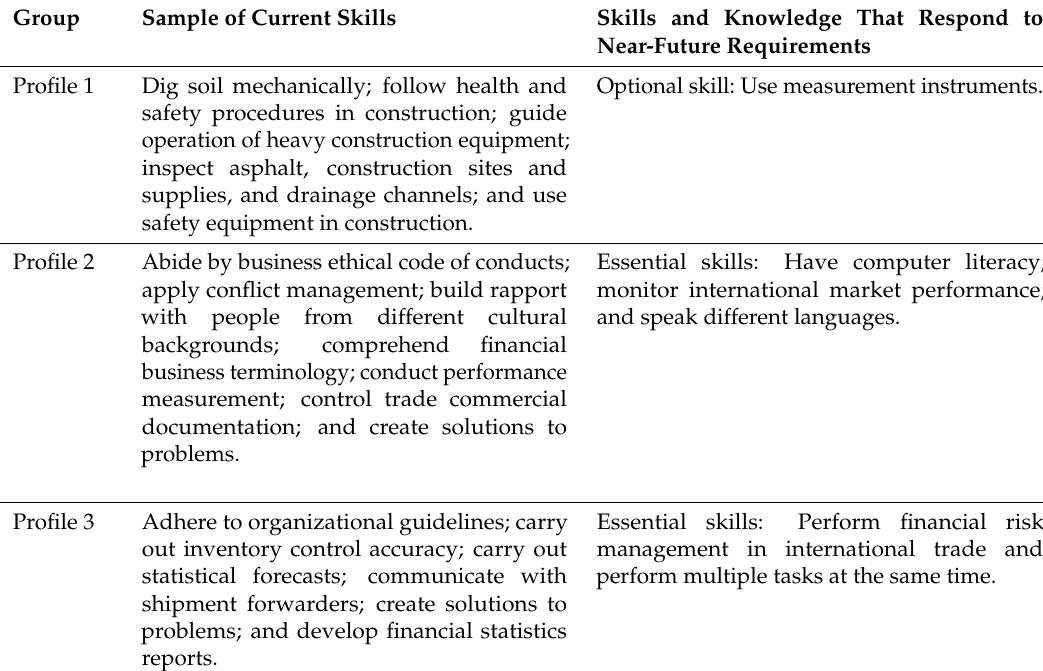
Table 2. Current skills and knowledge in each professional